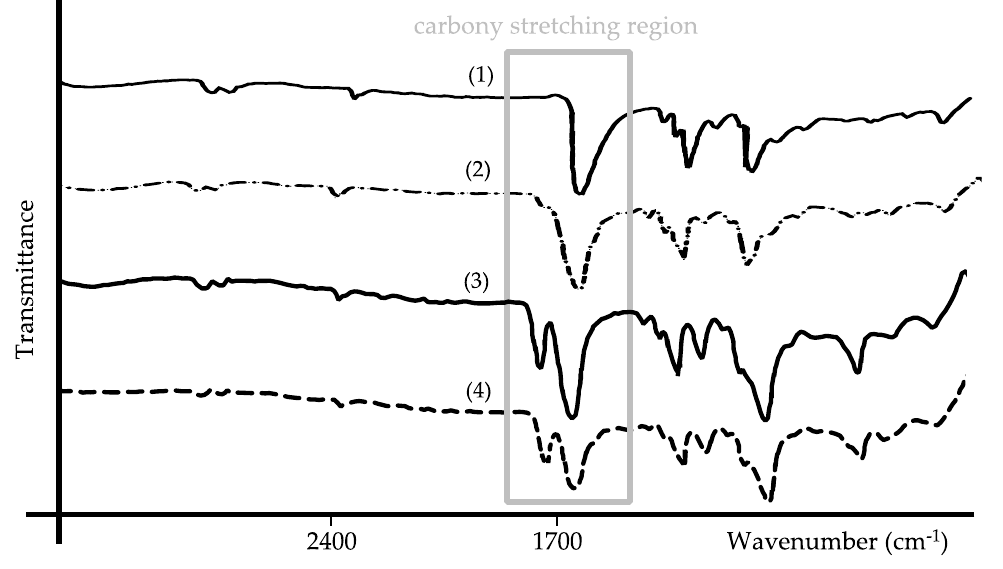
Figure 6. Fourier-transform-infrared (FT-IR) spectra of PVP (1), the CorA-PVP-ASD formulation (2), PVP/VA (3), and the CorA-PVP/VA-ASD formulation